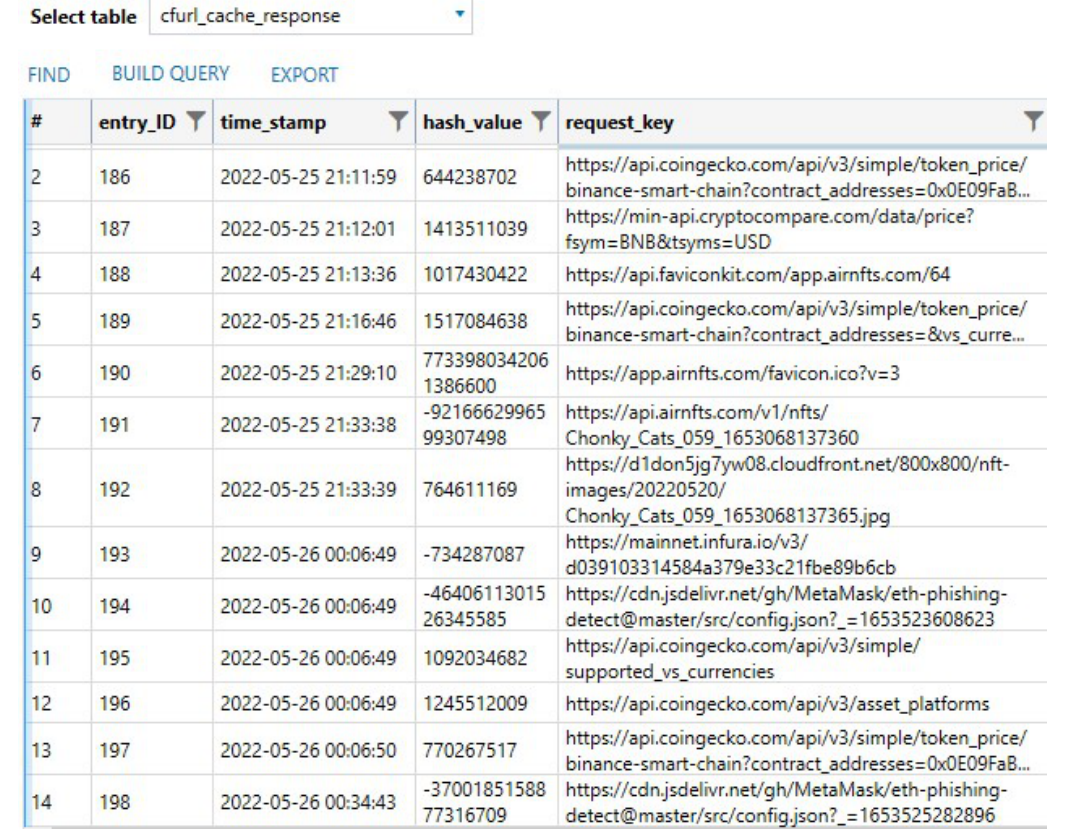
Figure 10. Recovered content from the cfurl_cache_response